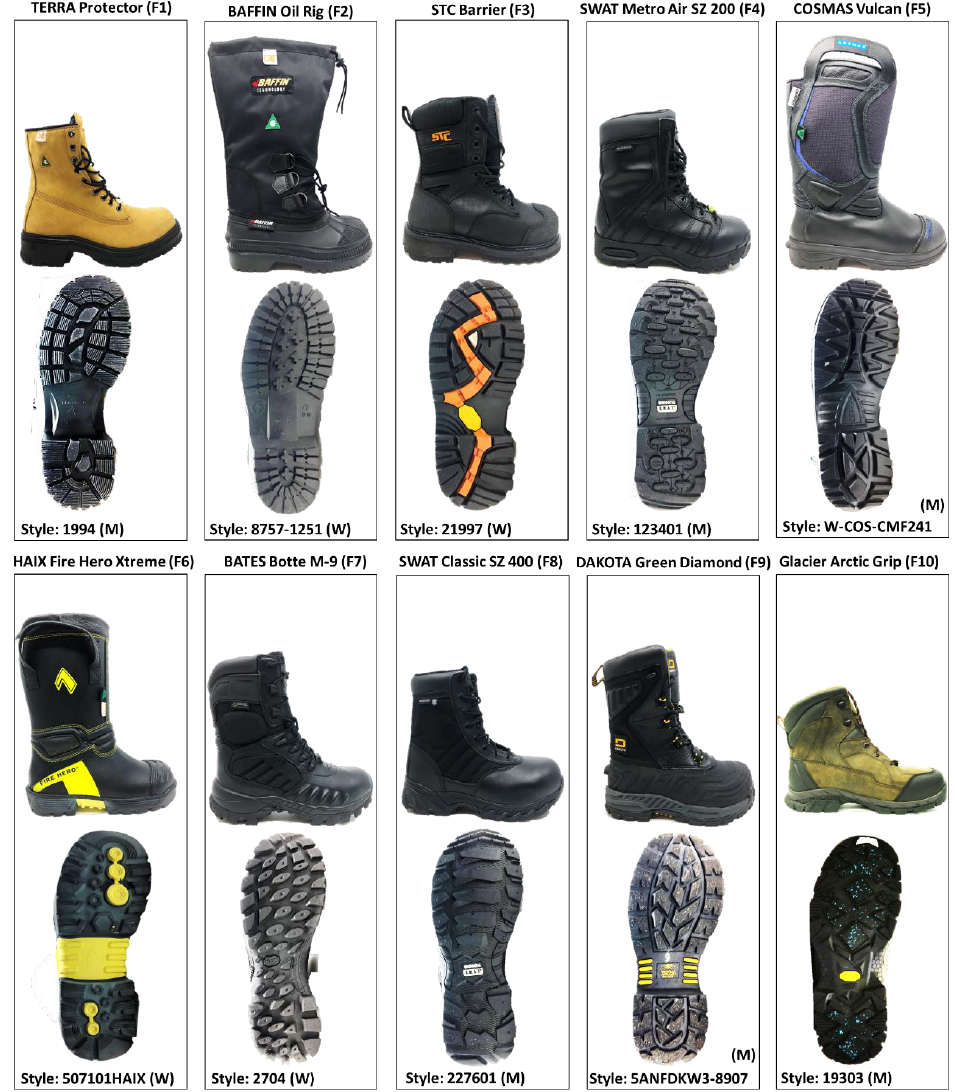
Figure 4. The ten types (F1–F10) of winter footwear tested in this study.